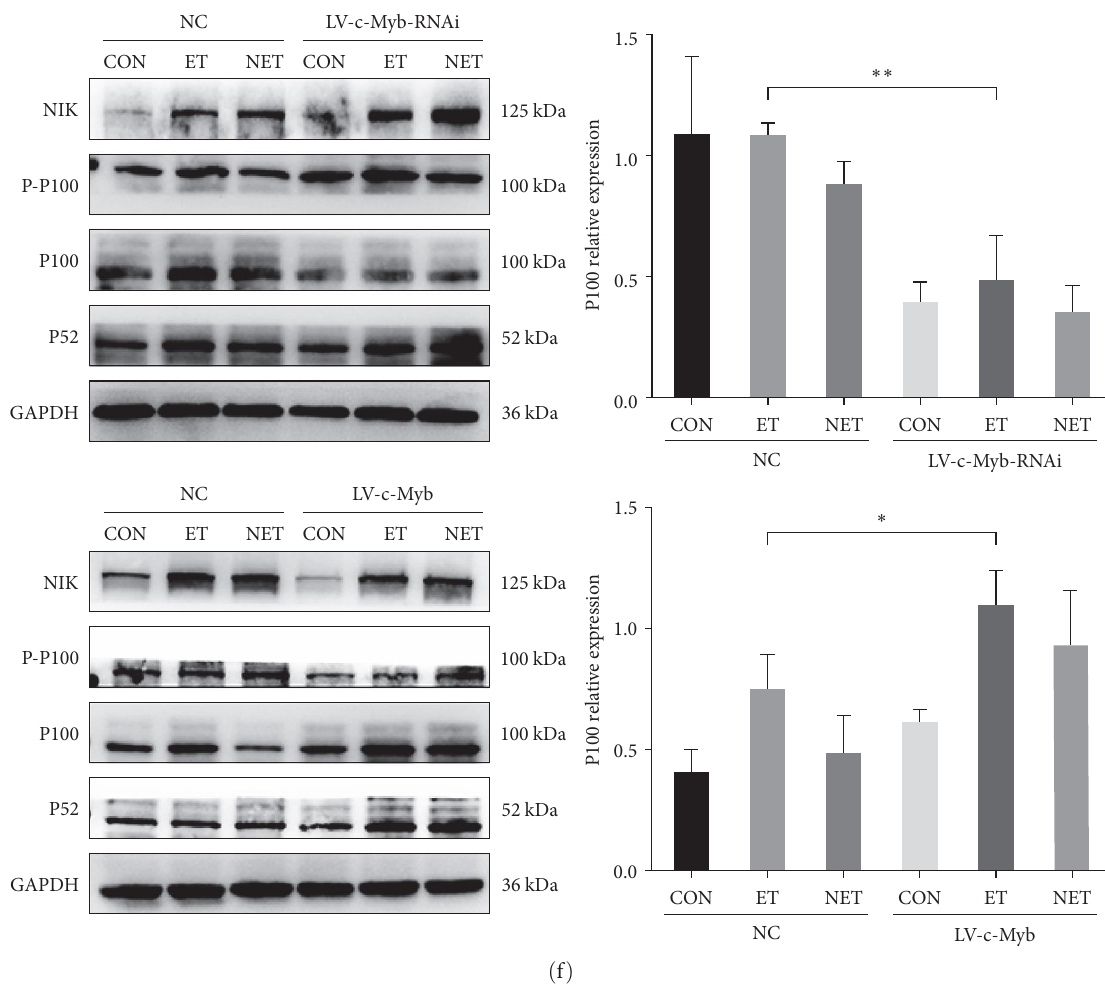
F IGURE 5: Overexpression of c-Myb enhances endotoxin tolerance: (a) lentiviral particles (LV-c-Myb-RNAi) were used to decrease c-Myb expression in RAW264.7 cells. Western blotting was used. Densitometric analysis of the Western blotting data; (b) phosphorylation of TBK1 was detected by immunohistochemical staining (400x); (c) H & E (400x) staining of liver sections in each group. Arrow indicated the in fi ltration of in fl ammatory cells; (d) detection of serum ALT and AST levels in each group. One-way ANOVA with Dunnett ’ s multiple comparisons was used; (e) lentiviral particles (LV-c-Myb) were administered to increase c-Myb expression. Western blotting was used; (f) Western blotting results show the protein expression of NIK, P-P100, p100, and p52. Densitometric analysis of the Western blotting data. The two-tailed Student ’ s t -test was used to test for statistical signi fi cance; data are represented as the mean Æ SD of at least three independent experiments; ∗ p < 0 : 05, ∗∗ p < 0 : 01, ∗∗∗∗ p < 0 :